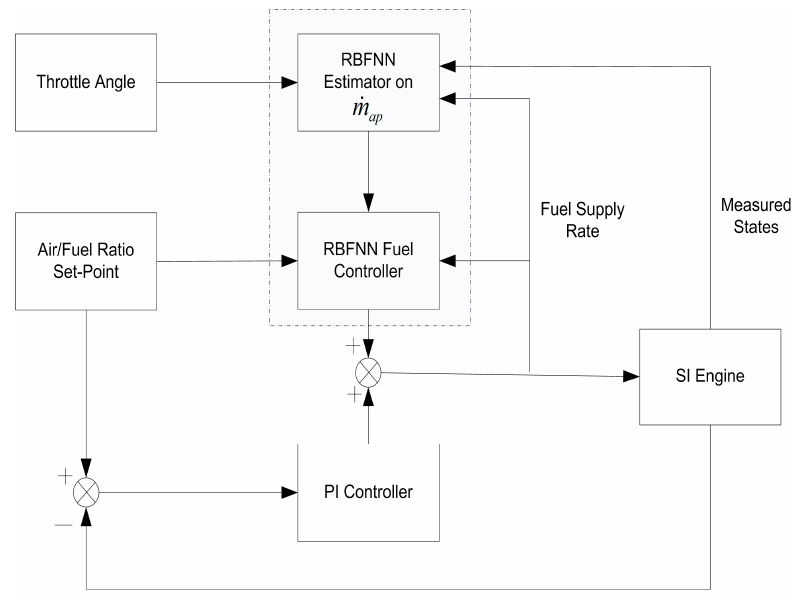
Figure 5. Neural Network-based feedforword and feedback control scheme on AFR.